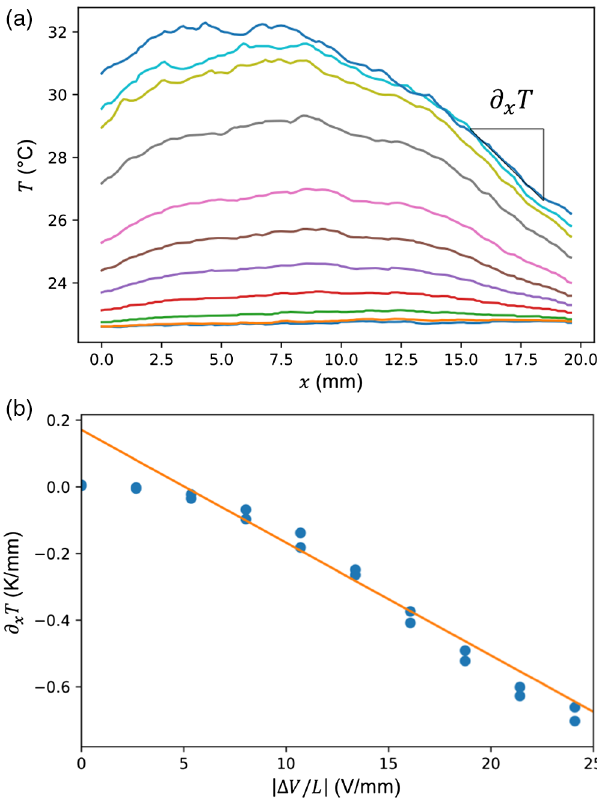
FIG. 3. (a) Stationary temperature profile (after 50 s) for different applied voltage ( L ¼ 19 mm, R ¼ 3 . 7 mm, and ϕ 0 . 11% ). Voltage varies from 0 to 1000 V with a 100 V i ¼ step from bottom to top. The black line shows the fit used to extract the temperature gradient for 1000 V. (b) Temperature gradient at the top of the foam deduced from a linear fit of temperature profile [see (a)]. The line is a linear fit, ∂ T ¼ − kE þ b , with k ¼ 0 . 034 K = V and b ¼ 0 . 18 K = x